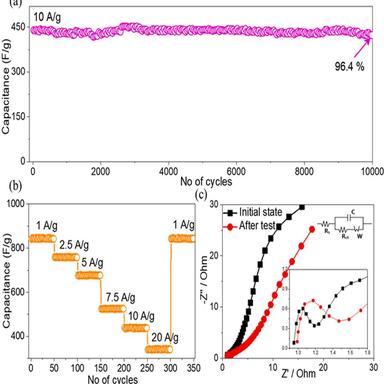
(a) Cycling behavior of Co-O-NSs@CFC electrode at a current density of 10 A/g, (b) rate performance of Co-O-NSs@CFC electrode at various current densities, (c) Nyquist plot of EIS for the initial and after cycling stability test.